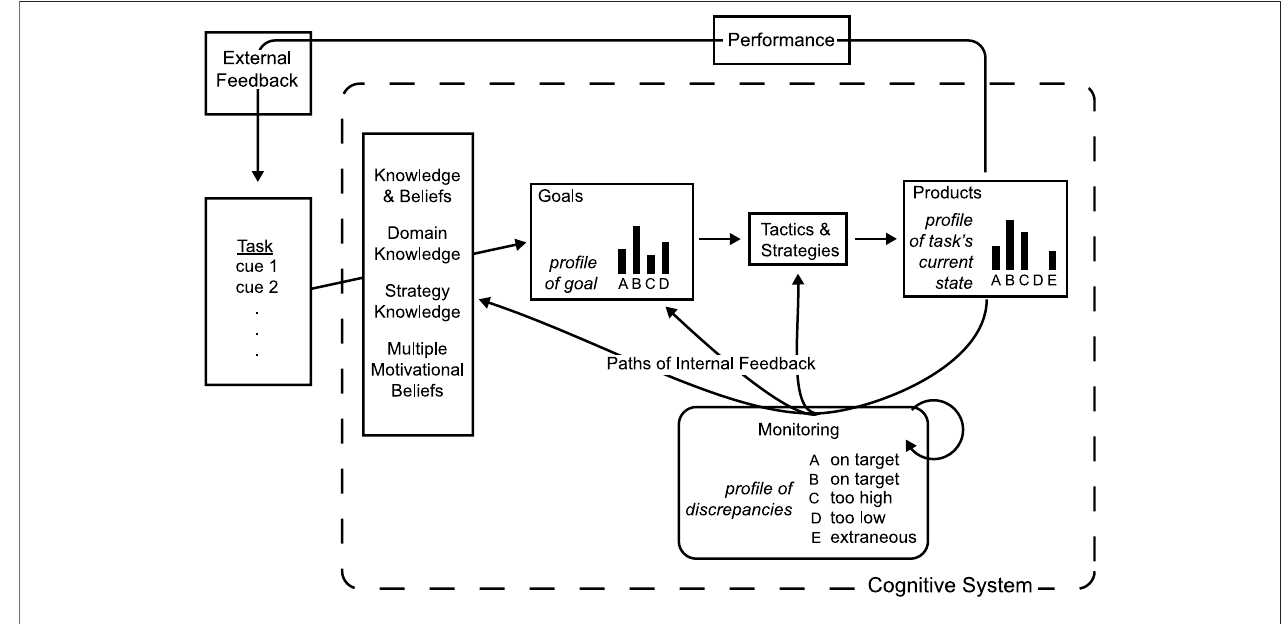
FIGURE 4 | First version of Winne ’ s SRL model (extracted from Winne, 1996).